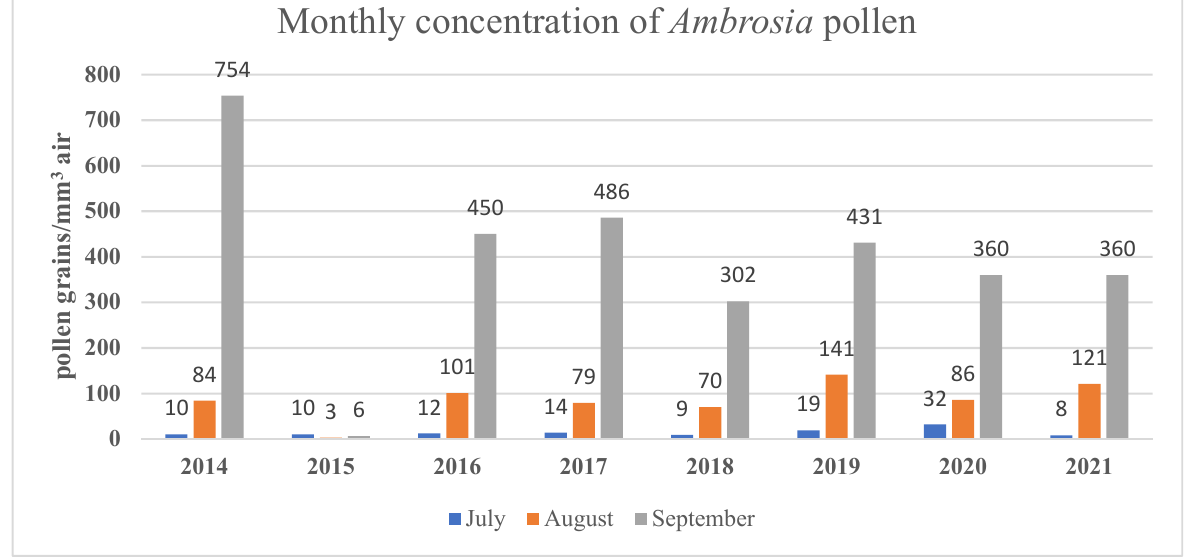
Figure 3. Monthly concentration of Ambrosia pollen during July–August–September, 2014–2021.